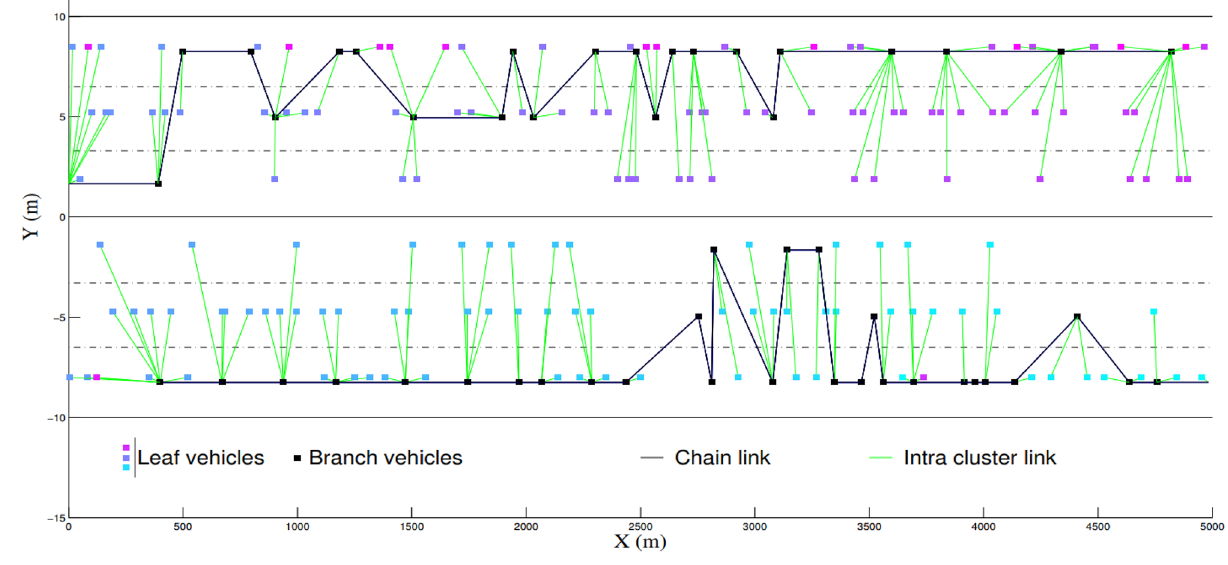
Figure 1. Example of two CBL chains on a 2-way